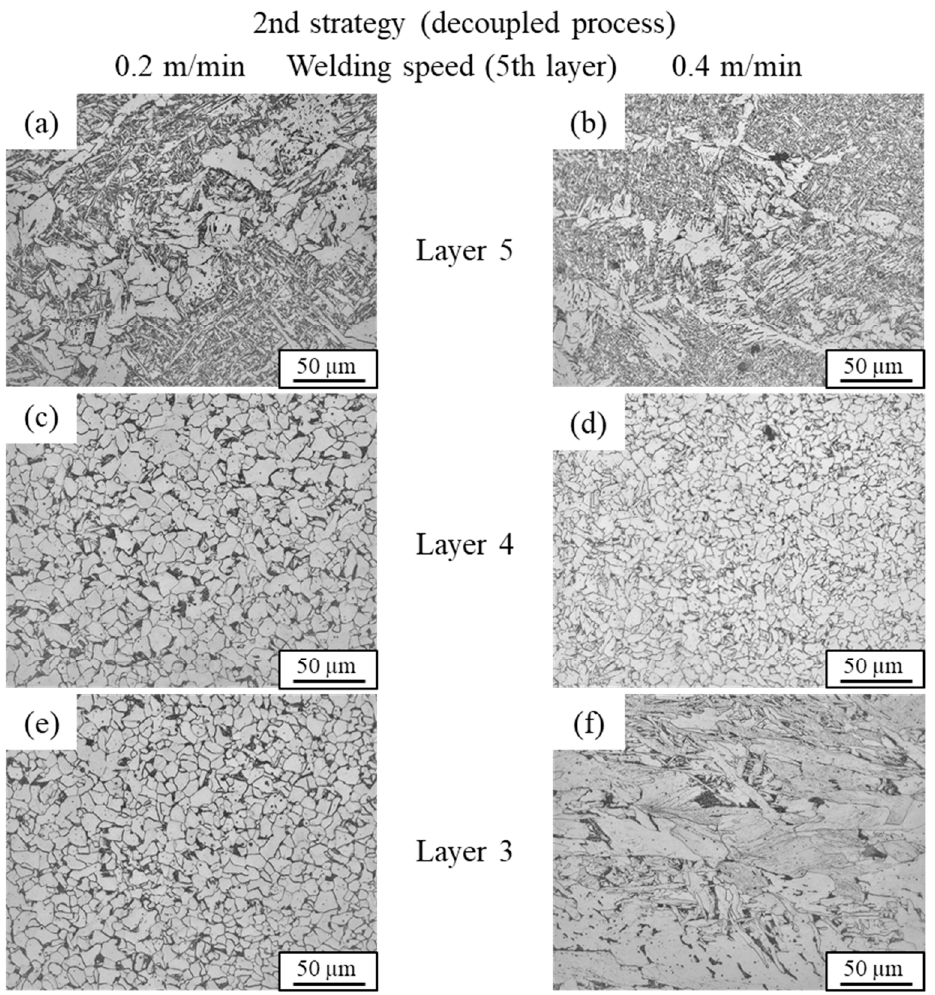
Figure 4. Metallographic analysis for strategy 2 (decoupled process), welding speed 0.2 m/min: ( a ) layer 5, ( c ) layer 4, and ( e ) layer 3; welding speed 0.4 m/min: ( b ) layer 5, ( d ) layer 4, and ( f ) layer 3.